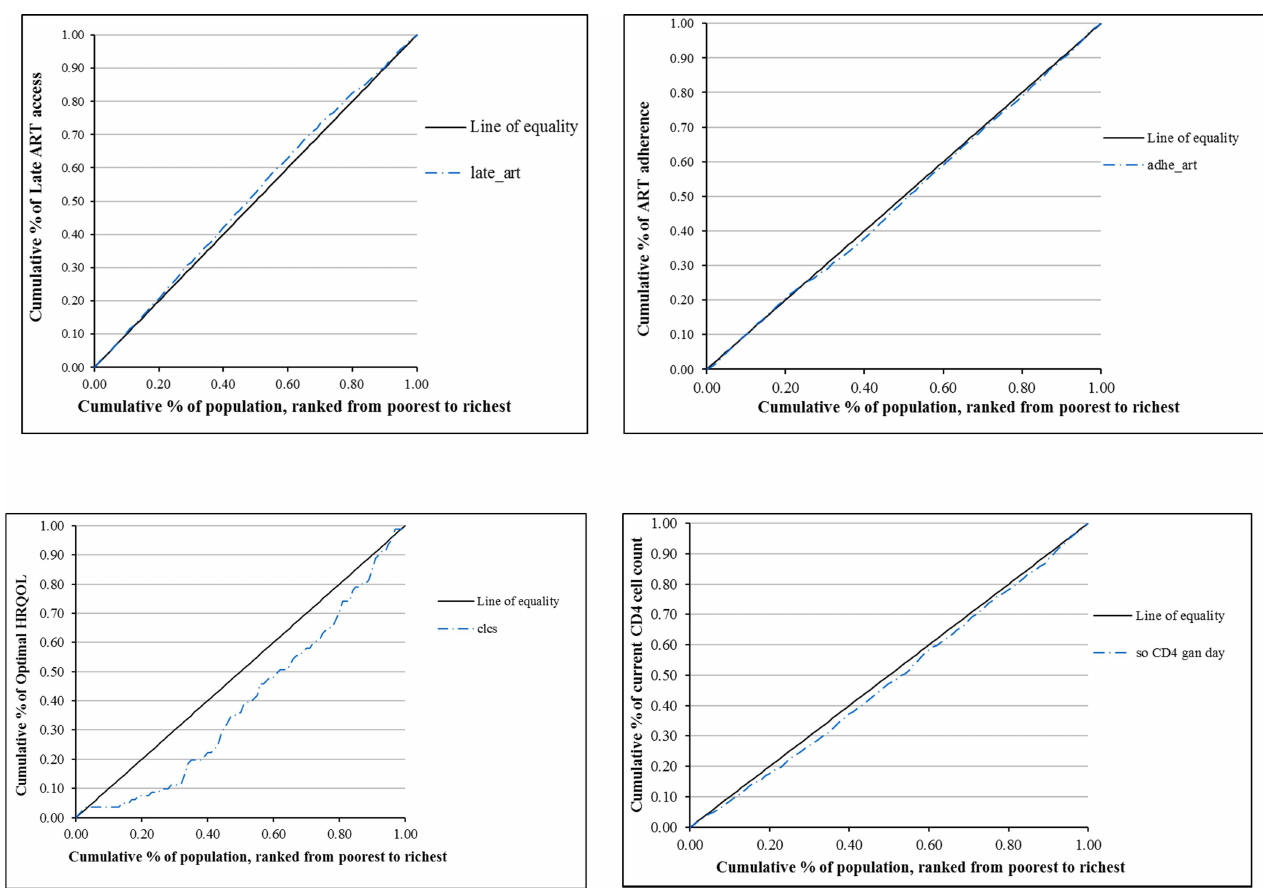
Fig 1. Concentration curves for the severity of inequality on access,adherence, and outcomes of ART services. (A) Late ART access (B) ART adherencetreatment (C) HRQOL (D) Current CD4 cell count.